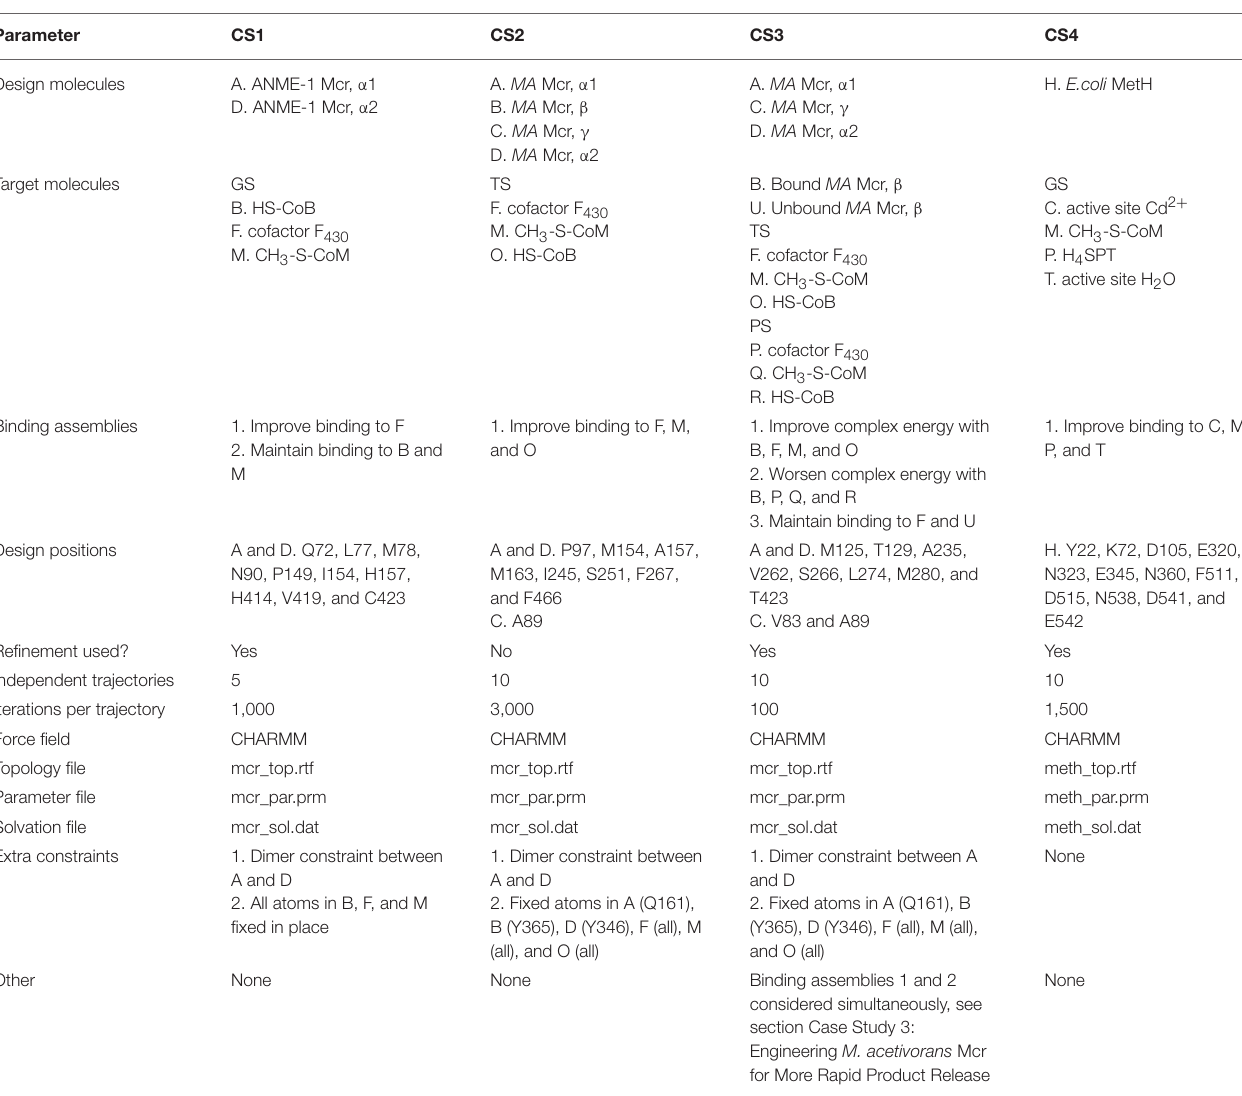
TABLE 5 | IPRO input parameters for CS1–CS4. Parameter CS1 Design